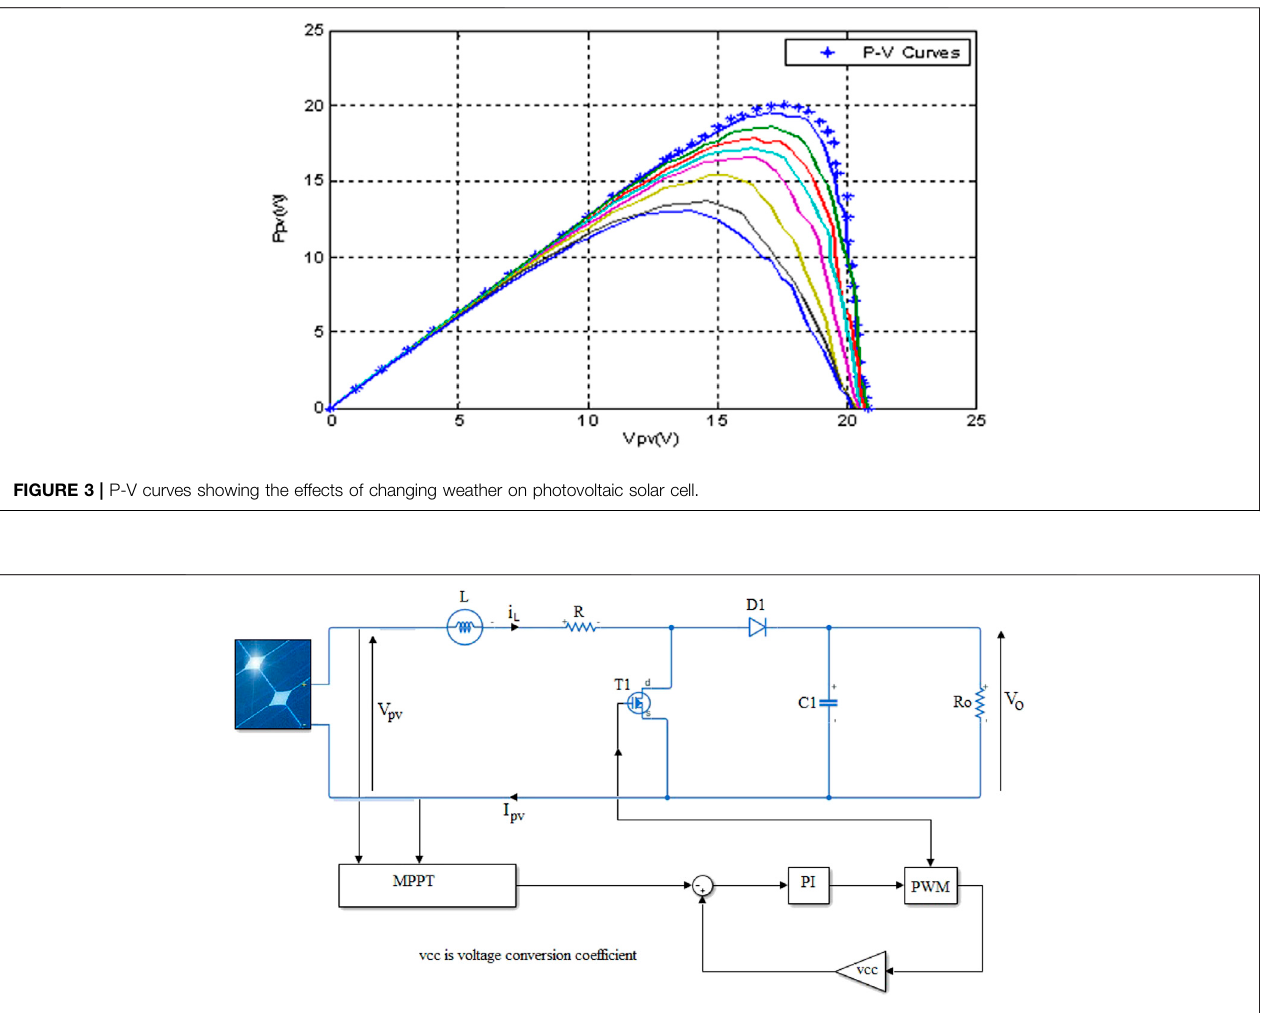
FIGURE 4 | Electrical circuit model to implement MPPT using RC.